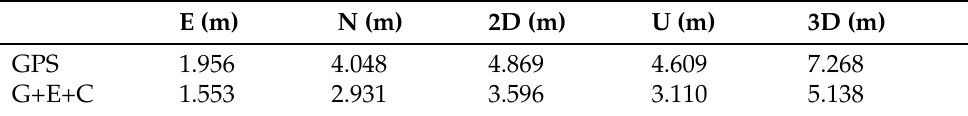
Table 6. Mean RMS values of SF RT–PPP performance in the east, north, 2D, up, and 3D directions for GPS and multi–GNSS from 10 to 20 September 2019.